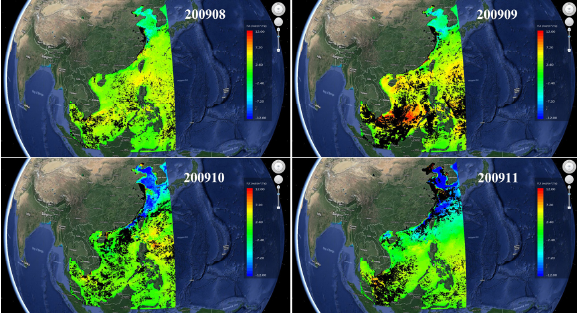
Figure 13. Air-sea CO 2 flux dynamic simulation over time represented by time-series satellite data.